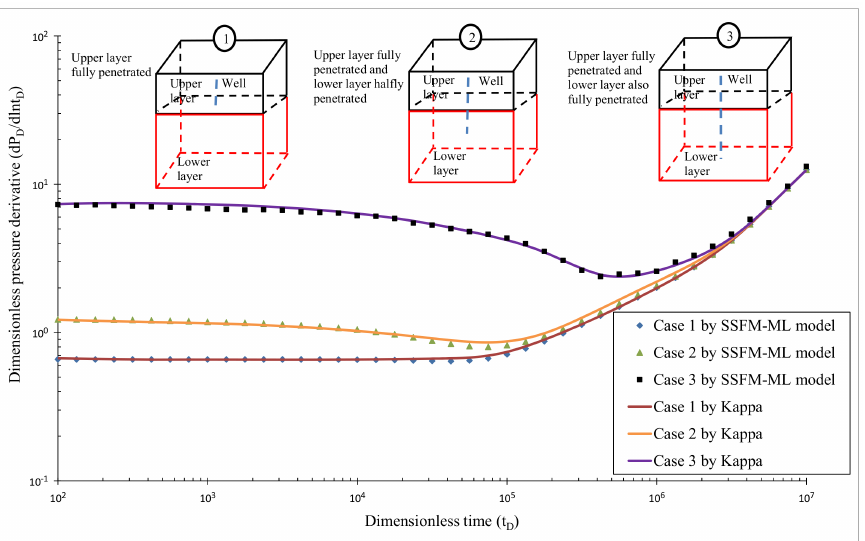
Figure 7. Effect of well penetration level in a 2-layer reservoir on dimensionless pressure derivative response. The dots are solutions generated by the SSFM-ML model using very short fracture length closely approaching a vertical well with L f 1 D = L f 2 D = 1, N stage = 1. The curves represent solutions generated by Kappa using its 2-layer reservoir model and partially penetrating well model with r wD = 1. They both have identical reservoir geometry and properties with x e 1 D = x e 2 D = 1000,